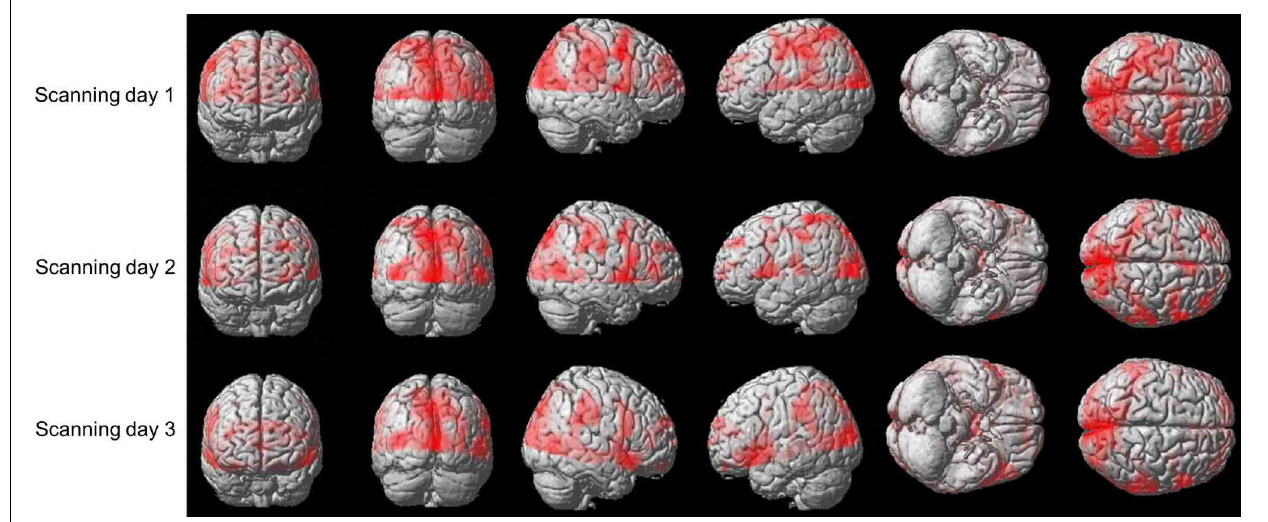
FIGURE 5 | Brain activation of subject #3 while practicing the SEQ condition in the 3 scanning days. Depicted is the activation ( t -stats for the contrast movement vs. rest) in the 12 axial slice (no gap) that were oriented parallel to the bi-commissural plane with the uppermost slice aligned 5mm below the